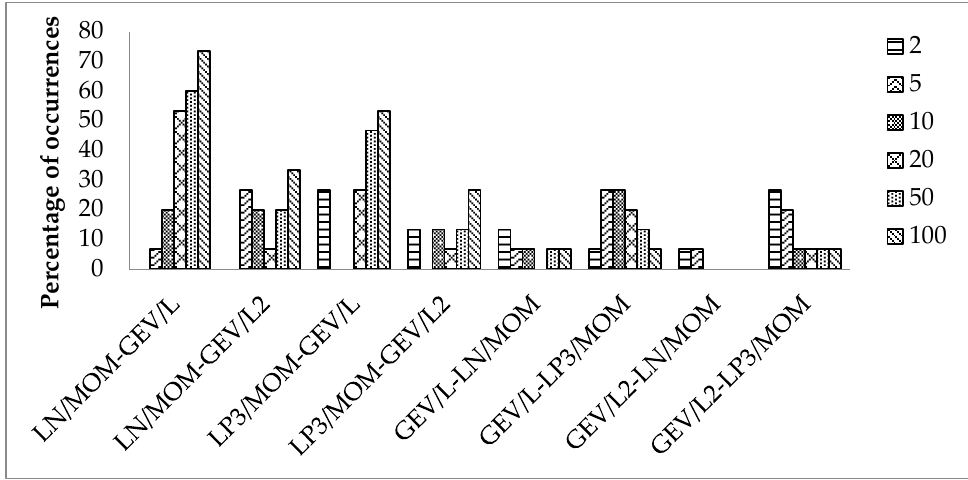
Figure 5. Comparison of the models using RMSE of 7-day minima series of the study catchments .